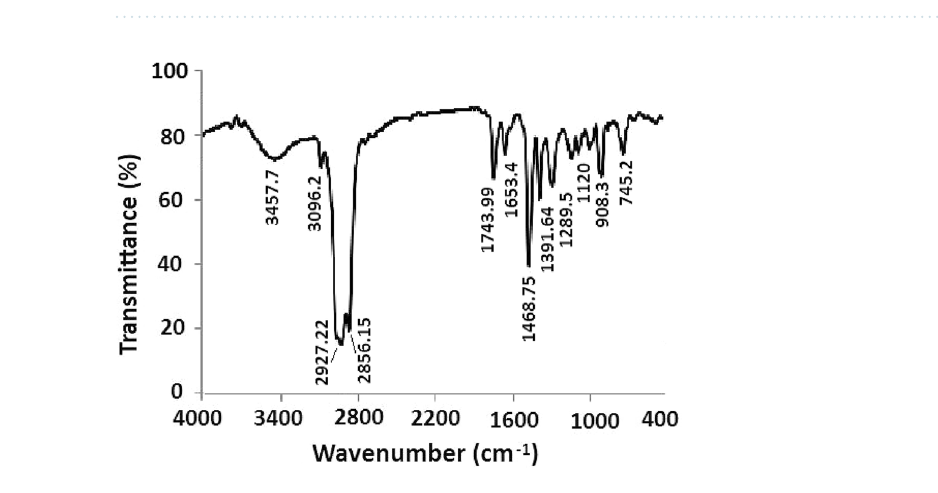
Figure 4. Effect of temperature of degraded yield of plastic based medical wastes.